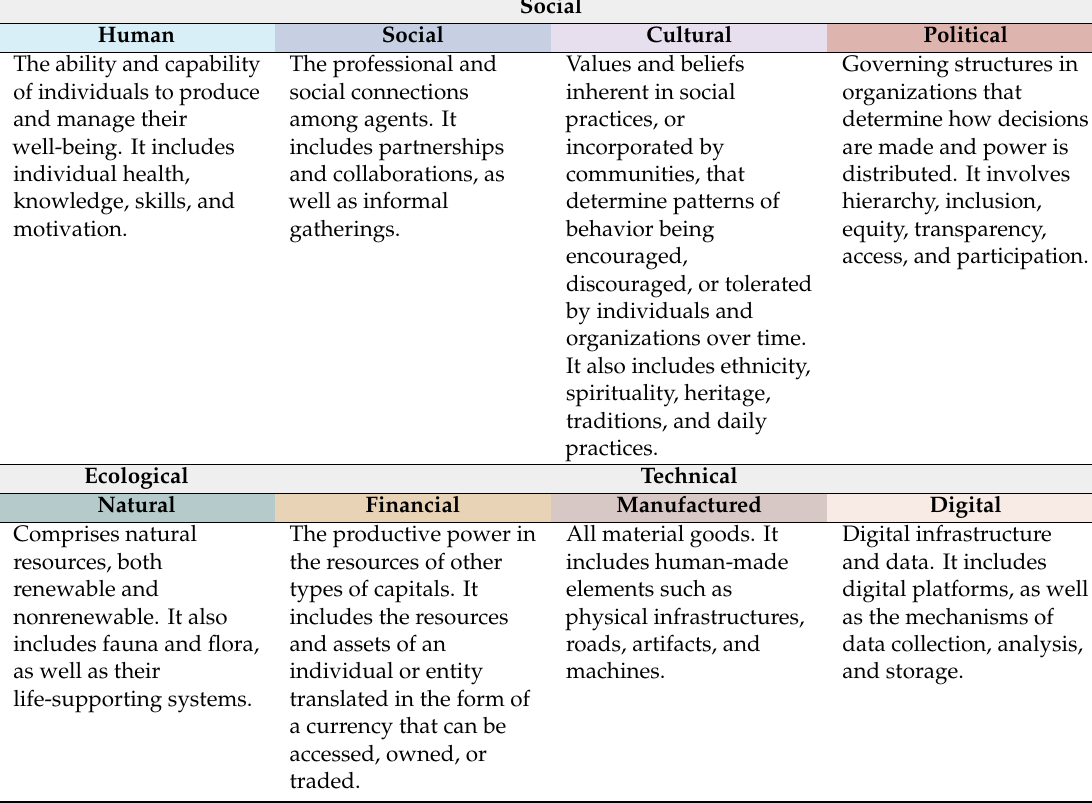
Table 1. Definition of the eight capitals as innovation lenses. Reprint with permission [54]; Copyright 2019,